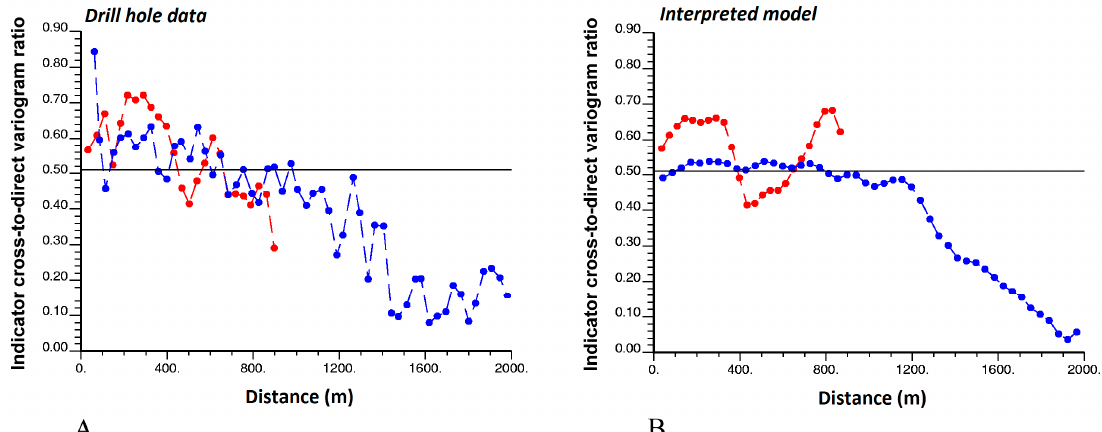
Figure 11. Absolute value of the ratio of indicator cross-to-direct variograms between rock types 2 (other volcanic rocks) and 3 (sedimentary rocks) along directions dipping 30° (blue) and − 60° (red) with respect to the north direction, calculated from ( A ) drill hole data, ( B ) interpreted model. Calculations consider an angle tolerance of 20° around the target directions. The same lag values have been used for both variogram ratios. The expected sill value (Equation (20)) is represented by a black solid line.